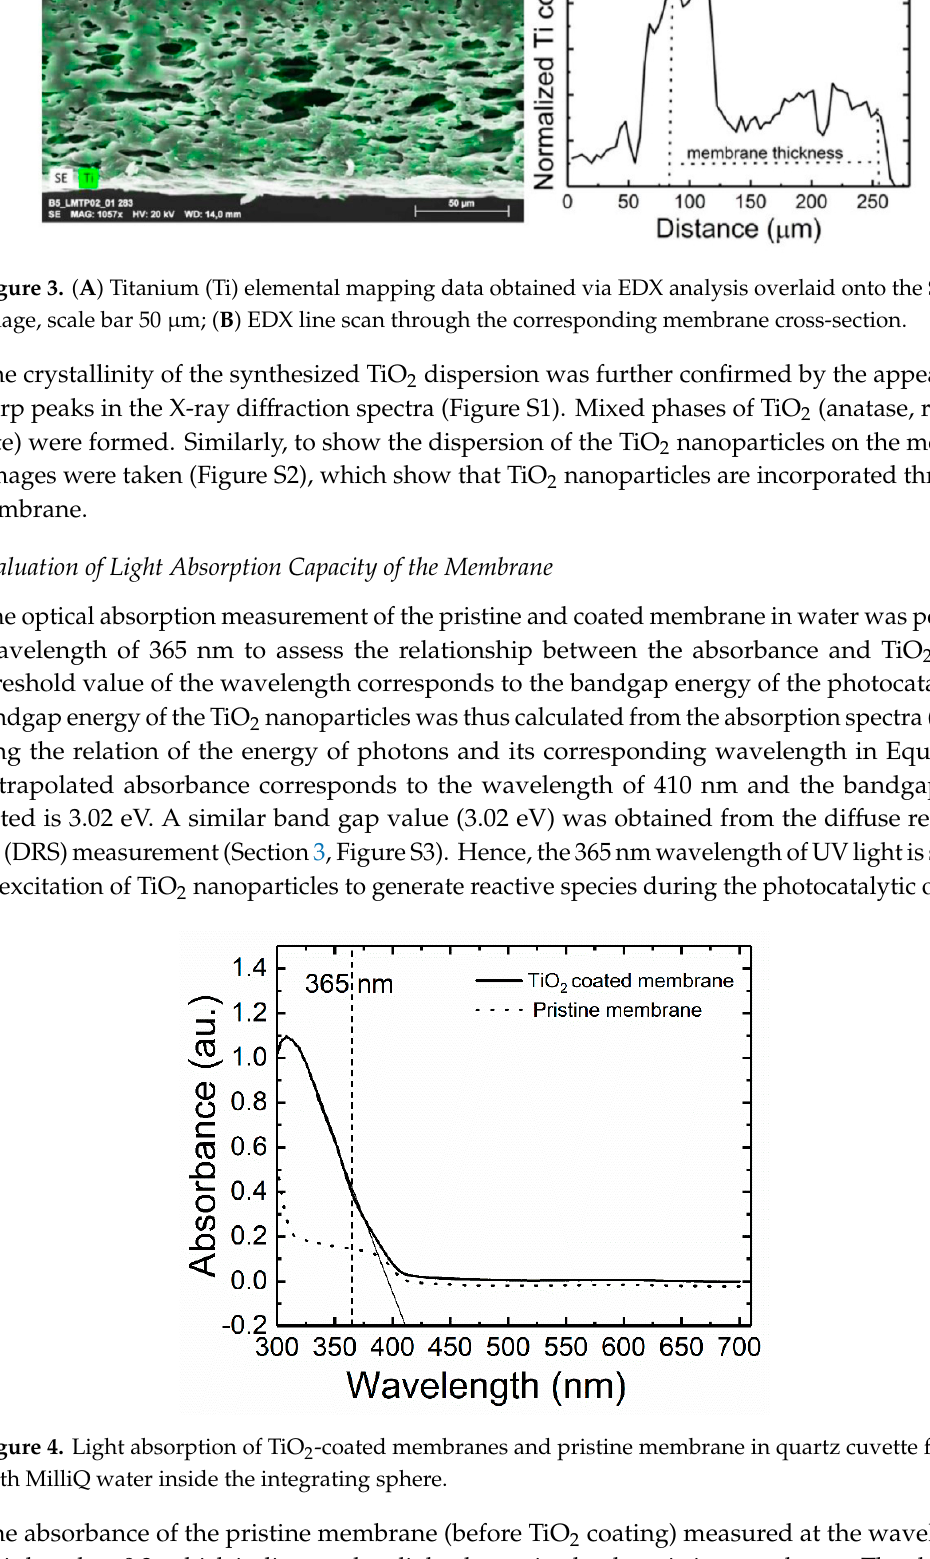
Figure 6. MB removal (filled) and photocatalytic membrane reaction rate (hollow) at different light intensities operated in the batch, flow-along and flow-through processes: flow rate 1 mL/min, MB concentration 1 mg/L, 22 °C, in flow-along and flow-through pH 8.6, 1 mM NaHCO 3 , 10 mM NaCl.